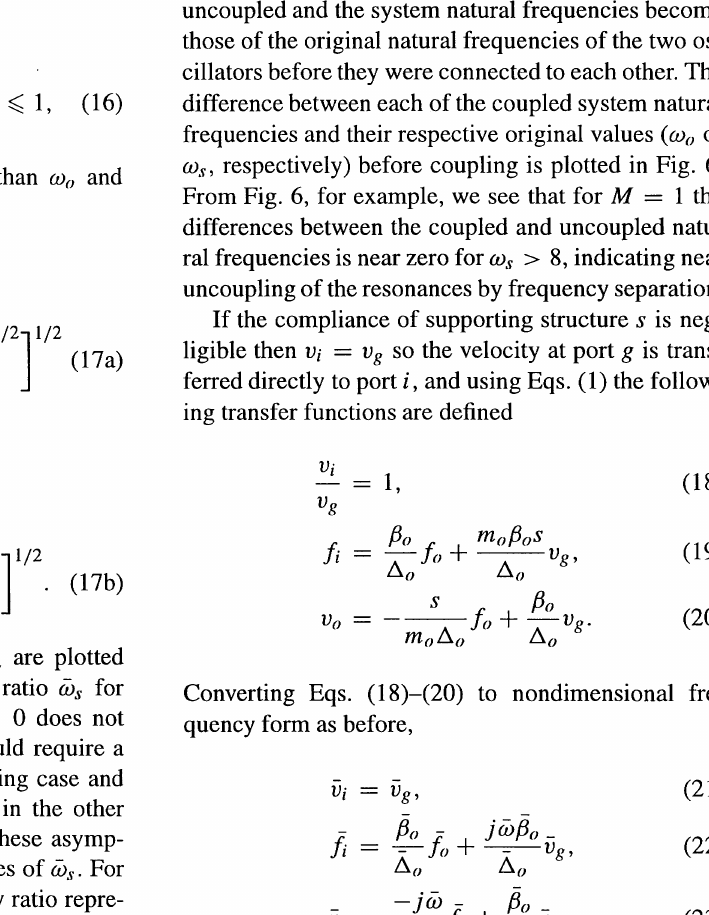
FIGURE 5 Natural frequency ratios as a function of frequency ratio for various mass